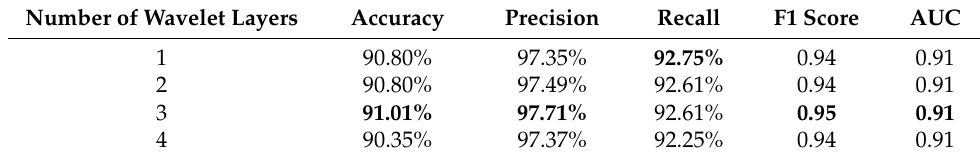
Table 8. The results of the experiment. Number of Wavelet